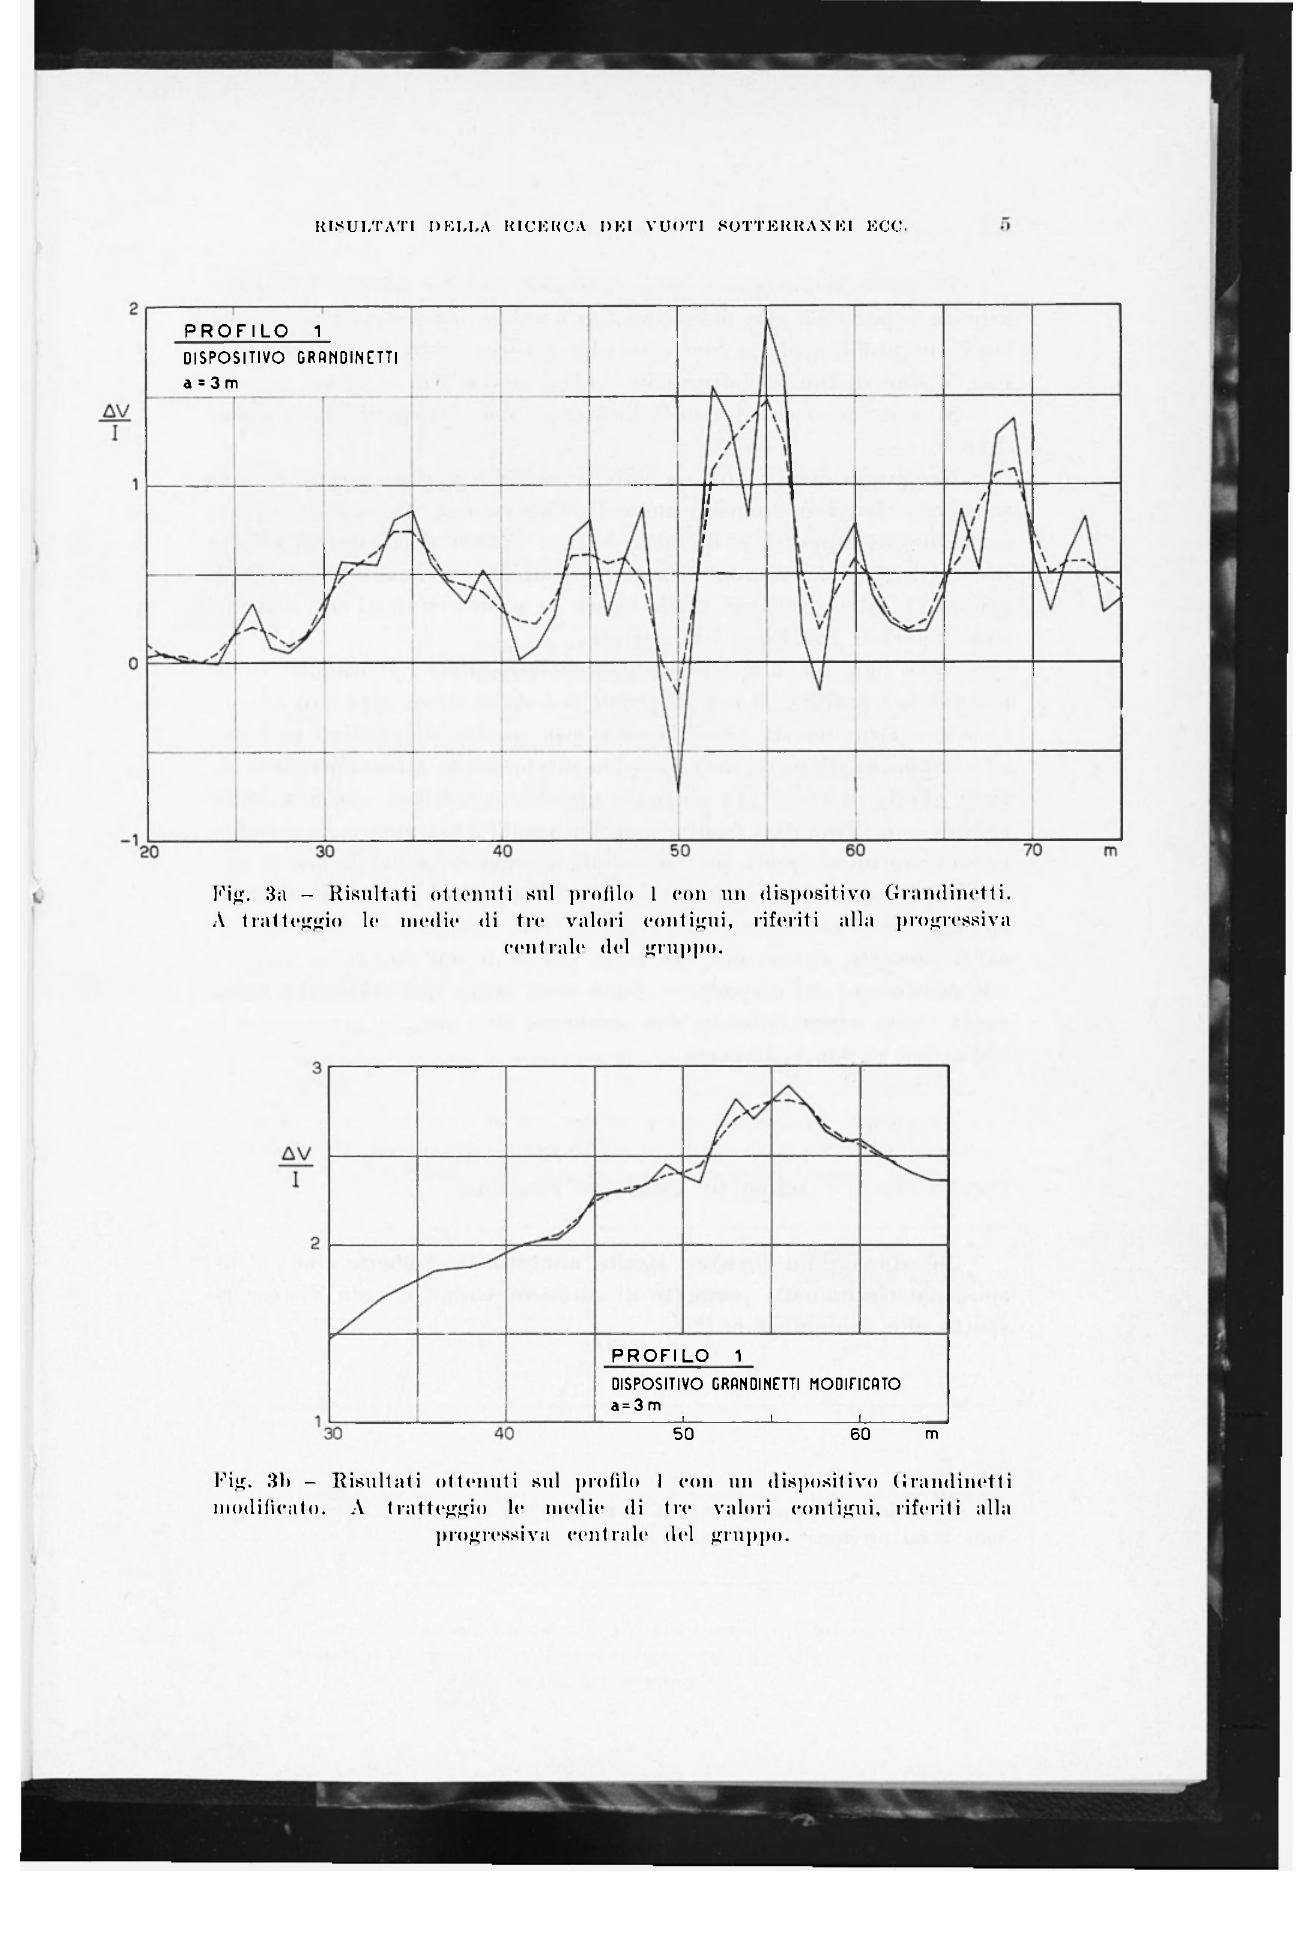
Fig. 3a - Risultati ottenuti sul profilo 1 con un dispositivo Grandinetti. A tratteggio le medie di tre valori contigui, riferiti alla progressiva centrale del